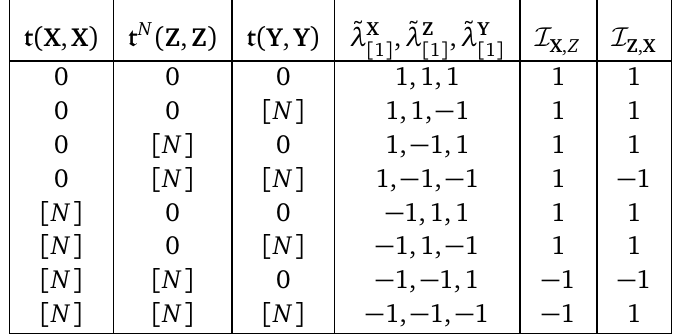
(cid:2) Z symmetry in U(1) 2 2